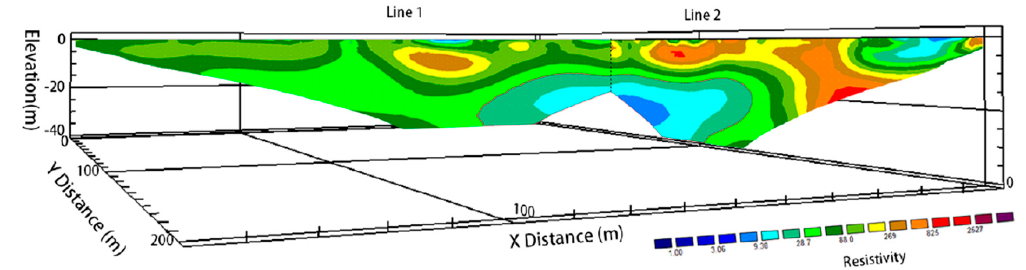
Figure 6. 2.5D seawater intrusion diagram.